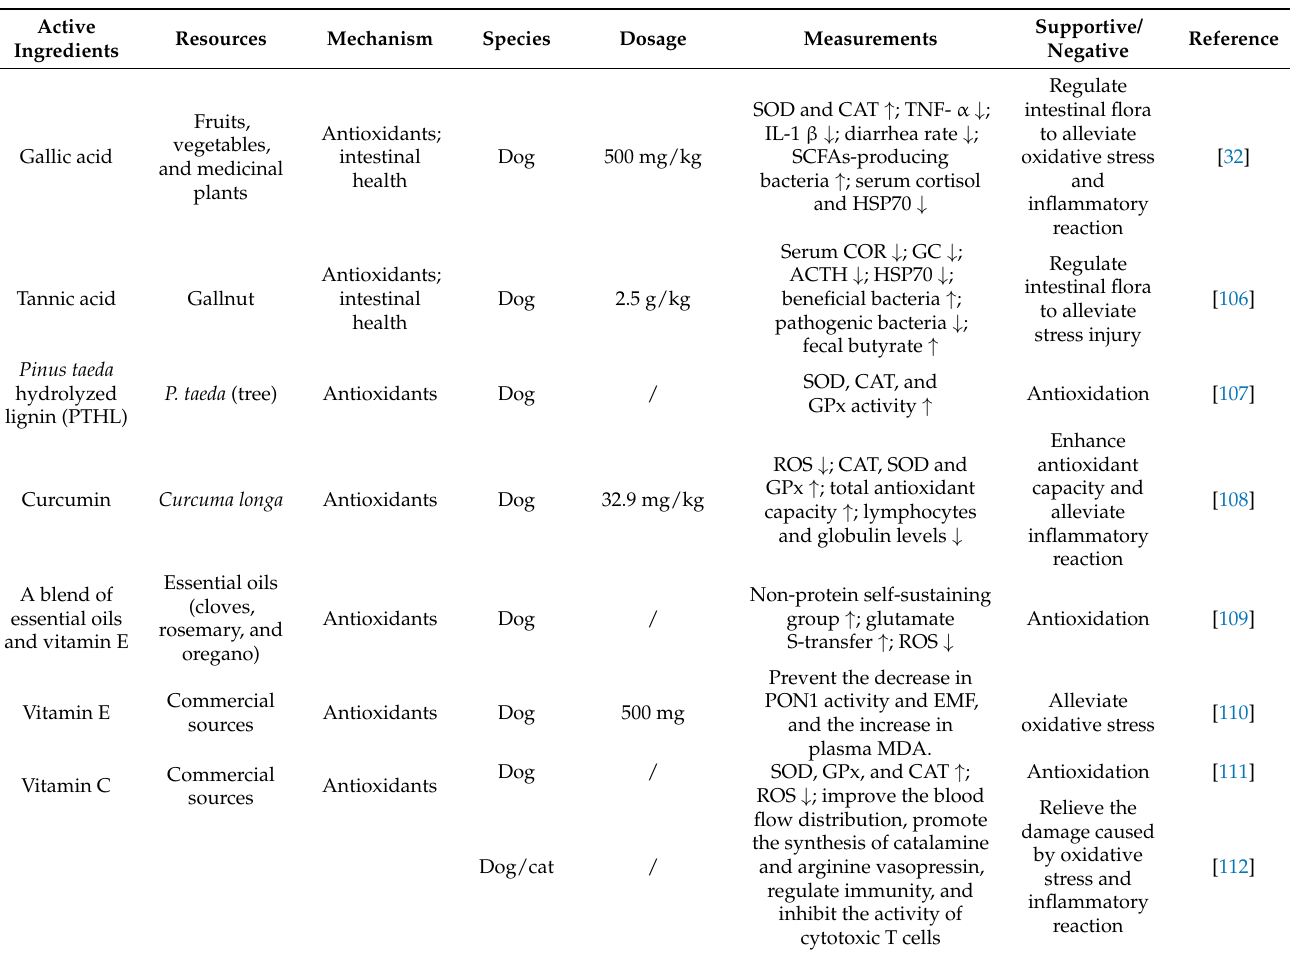
Table 1. Dietary strategies for stress alleviation in cats and